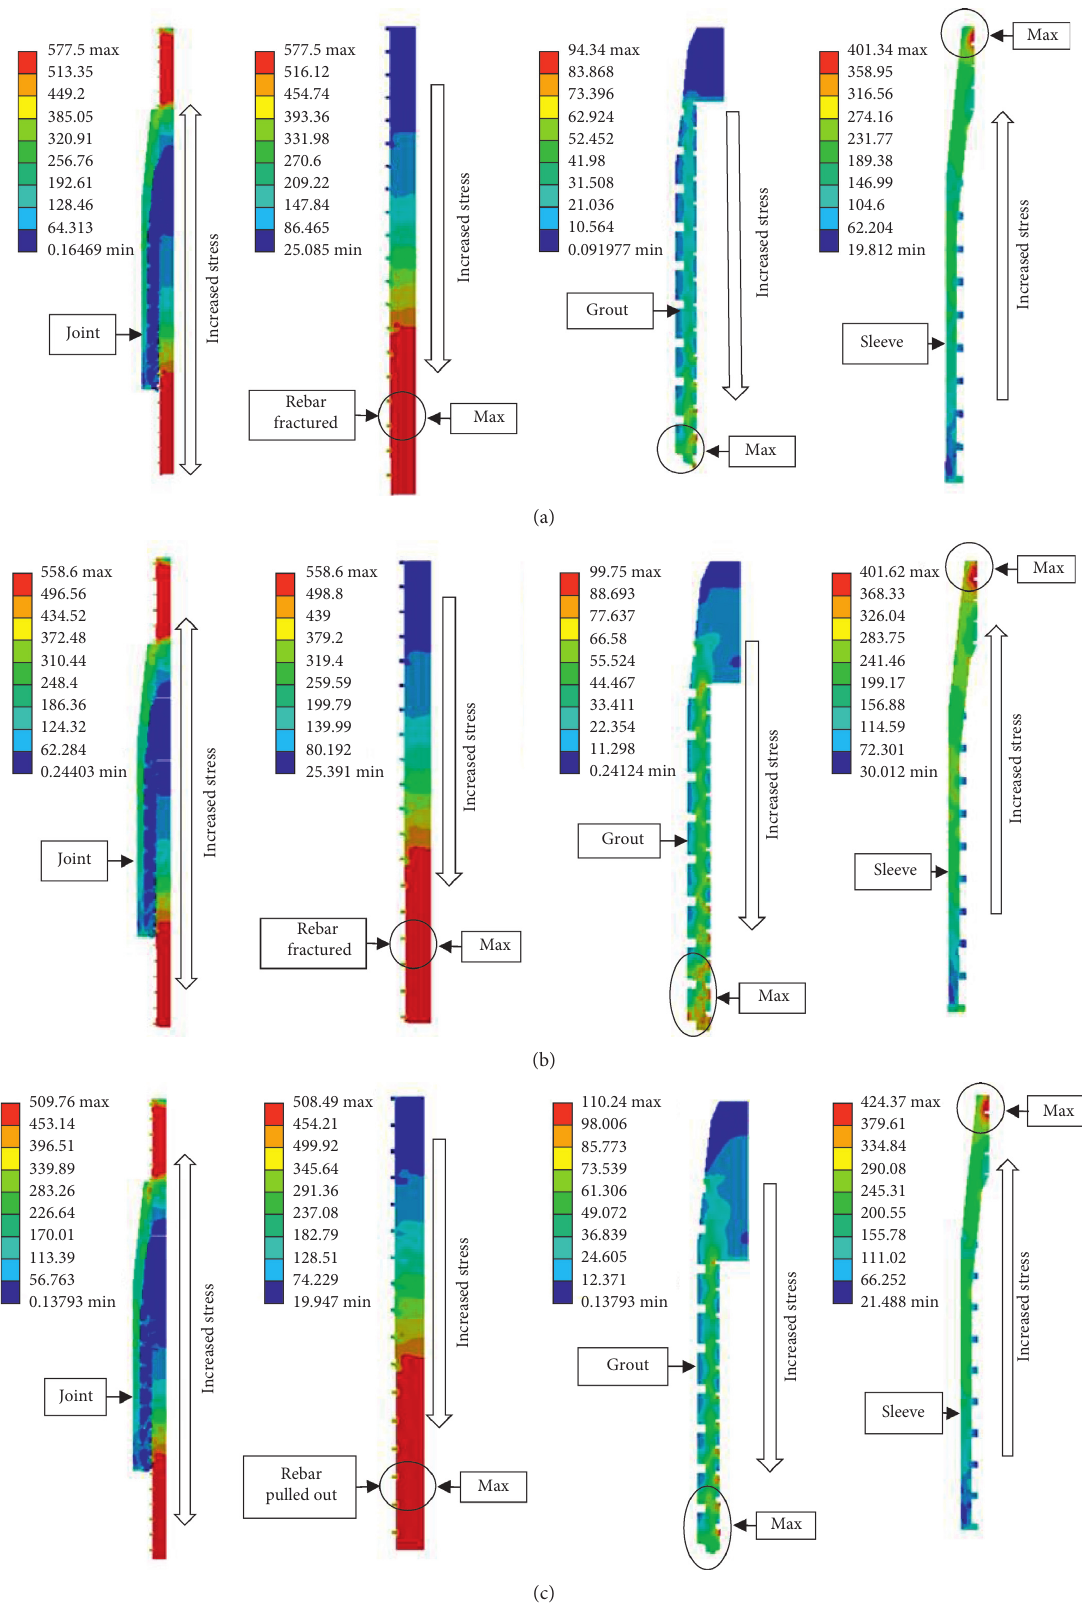
Figure 17: The finite element stimulation stress distribution diagram of the insufficient rebar anchor length specimen (unit: MPa). Rebar anchor: (a) 120mm (7.5d); (b) 104mm (6.5d); (c) 88mm